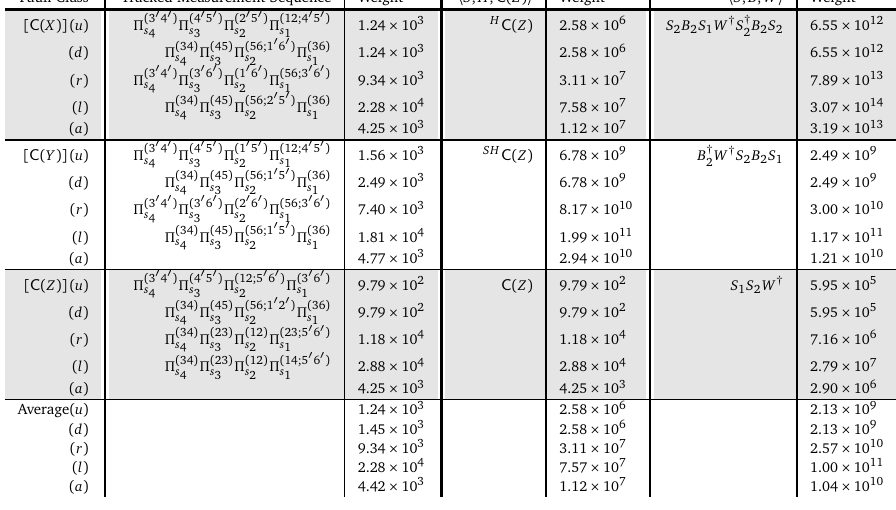
Table 17: Minimal difficulty weight measurement sequences for Pauli cosets of controlled-Pauli two-qubit gates when using Majorana-Pauli tracking methods. The labels ( u ) , ( d ) , ( r ) , and ( l ) indicates that for a hexon acting as the control qubit of the C ( P ) gate, the corresponding target qubit is the nearest neighbor hexon in the up, down, right, and left direction, respectively. Notice that the choice of control and target qubit is arbitrary for C ( Z ) , so ( u ) and ( d ) are related by symmetry, as are ( r ) , and ( l ) . The average difficulty weight of the four directions is labeled by ( a ) . For comparison, we also present the corresponding realization of the gates formed by using the generating gate sets 〈 S , H , C ( Z ) 〉 and 〈 S , B , W 〉 . A C ( Z ) = A C ( Z ) A † denotes conjugation of C ( Z ) by A on the target qubit. 2 2 Pauli Class Tracked Measurement Sequence